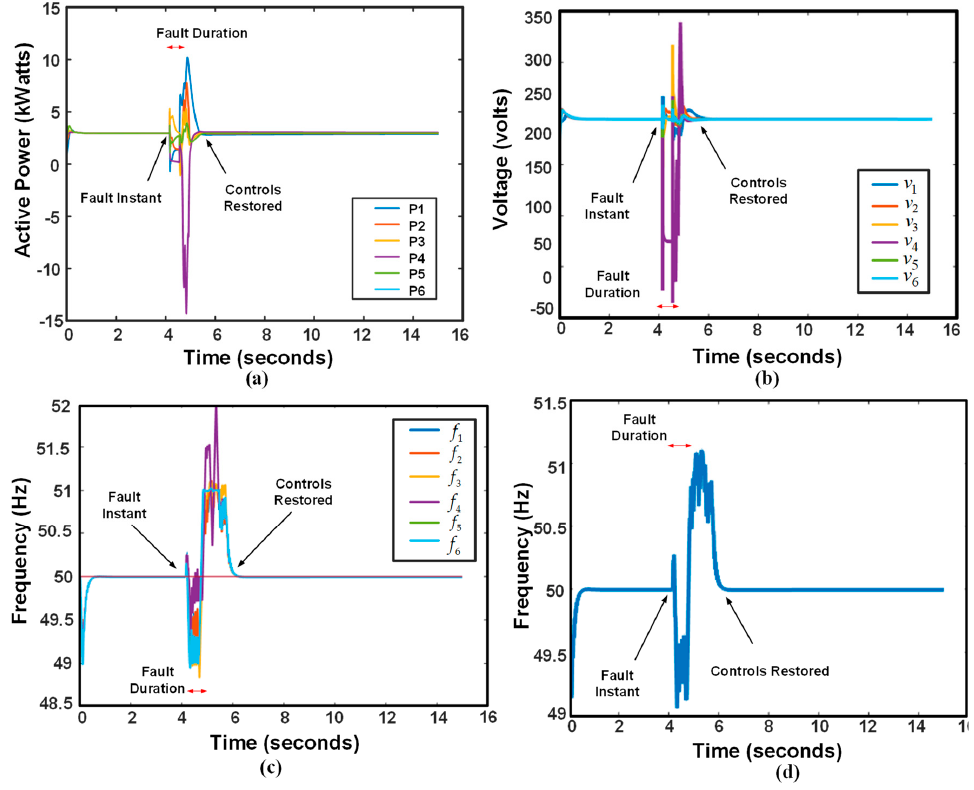
Figure 9. Performance of proposed Control Scheme under grid fault ( a ) Active Power sharing ( b ) Voltage regulation ( c ) Frequency regulation of individual inverters ( d ) Frequency measured at PCC bus. Table 4. Short Circuit Fault Parameters.